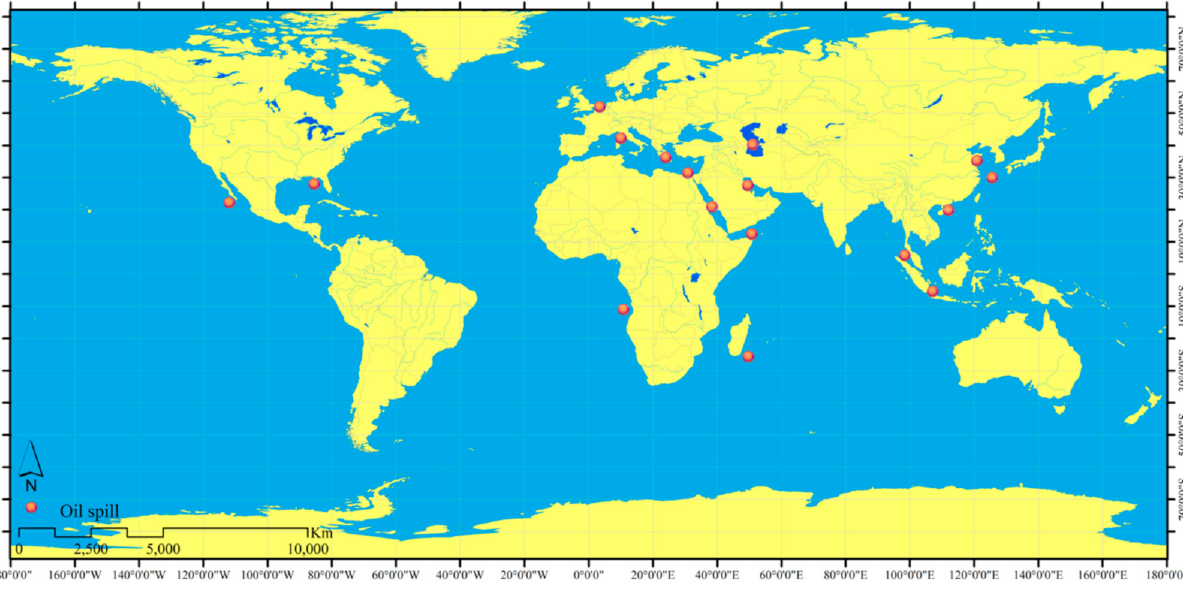
Figure 1. The location information of the oil-spill events used for model